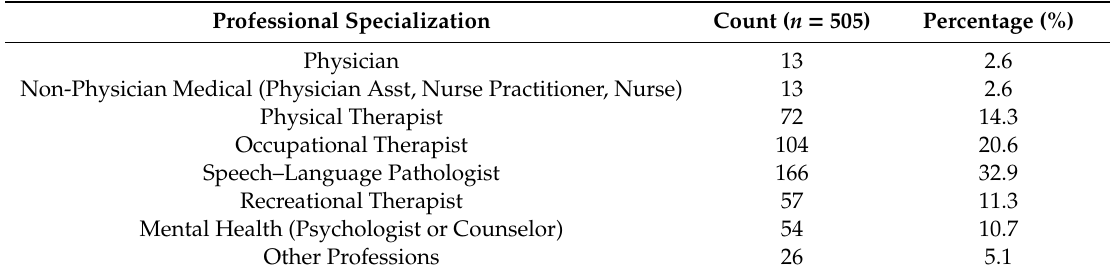
Table 1. Respondents by profession (number and percentage of sample).